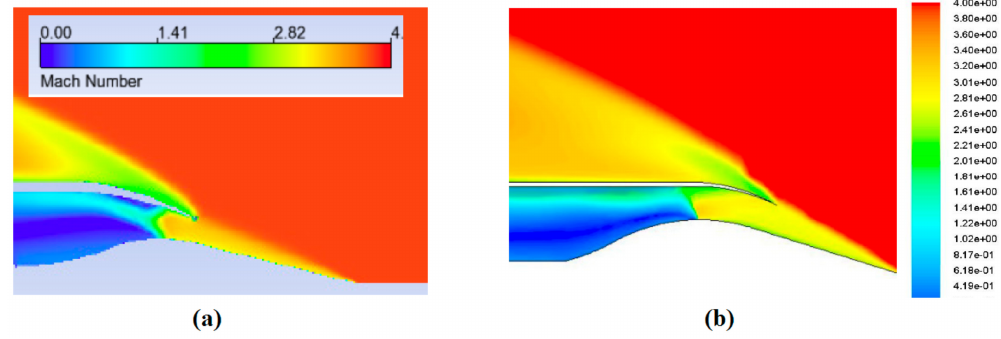
Figure 2. Validation comparison ( a ) verified CFD and ( b ) this paper’s